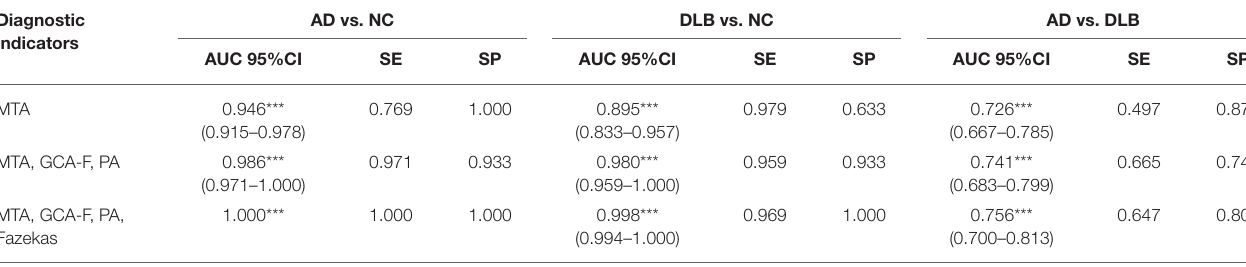
TABLE 4 | The ROC analysis results of different diagnostic indicators. Diagnostic